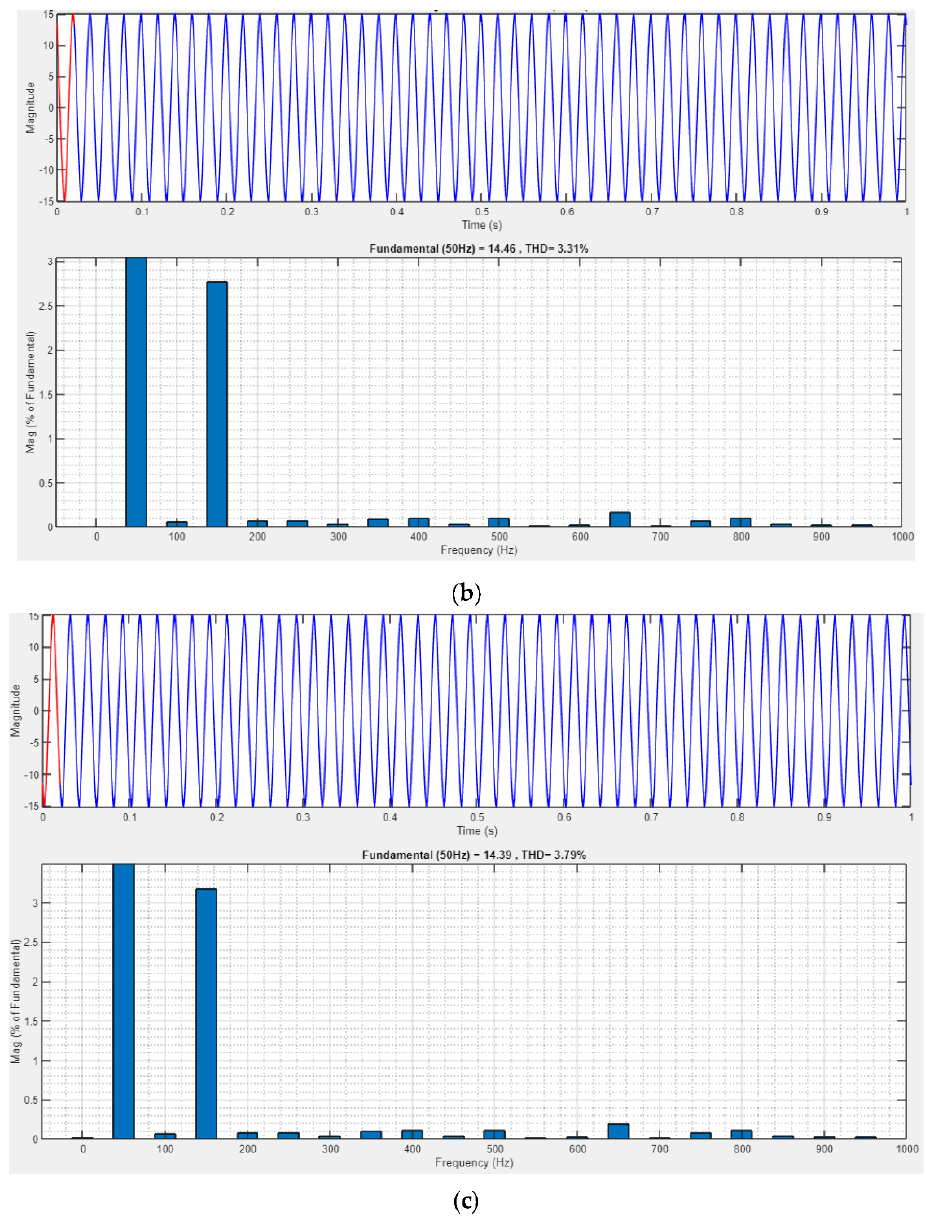
Figure 13. ( a ) R-phase input current THD, ( b ) Y-phase input current THD, and ( c ) B-phase input current THD. Figure 14 reflects the powers injected to 3P4W distribution network, i.e., both the active and reactive, load demand and converter requirement. The required active power supplied to the distribution system is from source and reactive power is negligible and power factor is improved to unity. Moreover, the necessary reactive power by load is pro- vided by four-leg VSC, as shown in Figure 14.